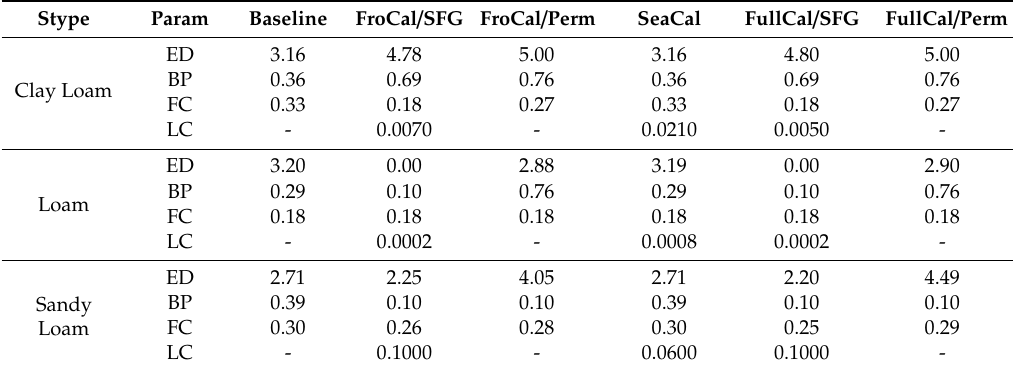
Table 2. Calibrated values of parameters connected to soil types in four calibration steps. Baseline, FroCal, SeaCal and FullCal stand for calibration Steps 1 to 4, respectively; Perm stands for the permafrost area and SFG the seasonally frozen ground area. SType is short for soil type and Param for parameter. Dash indicates the non-sensitive parameter. Ranges: ED ( ≥ 0), BP ( > 0), FC (wilting point to porosity), LC ( > 0). The values are round to two decimal places except for LC, which keeps four digits. Stype Param